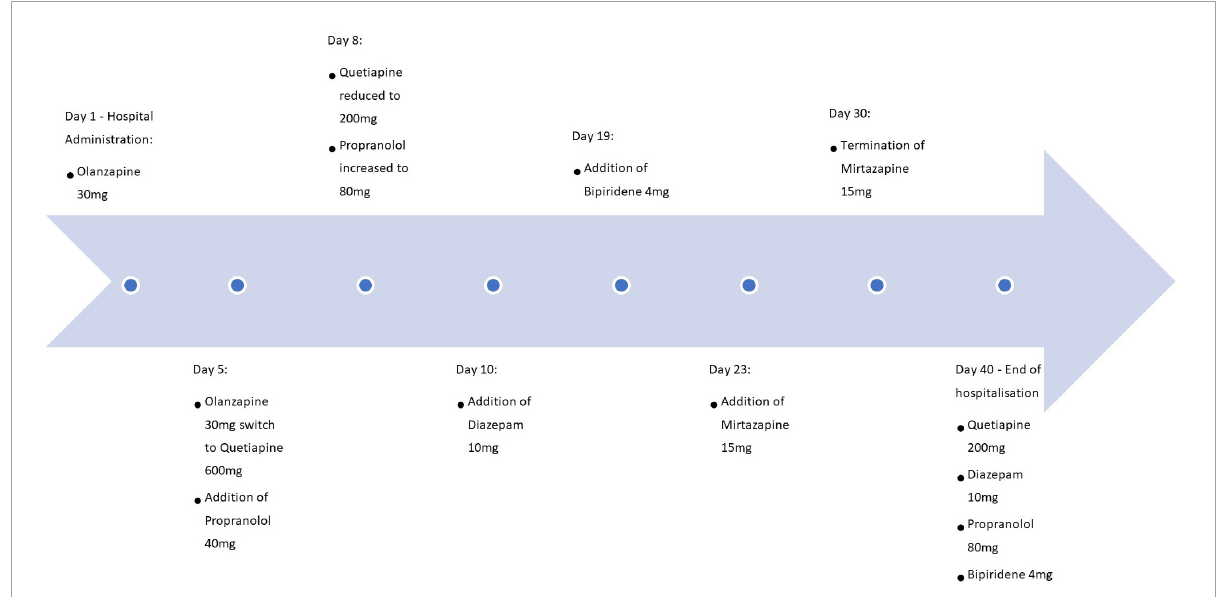
FIGURE1 Timeline of pharmacological treatments.